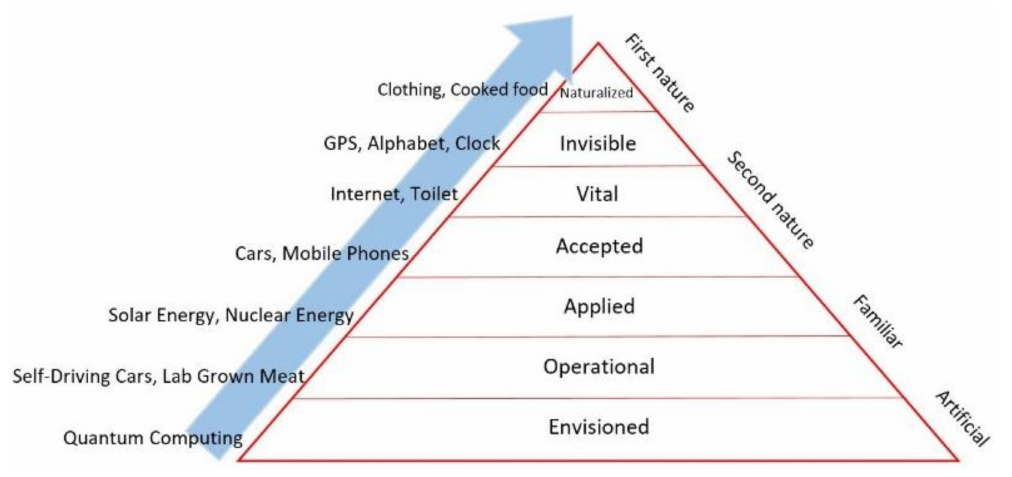
Figure 3. The pyramid of